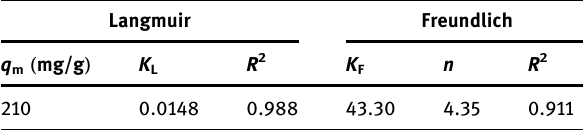
Table 2: The parameters of Freundlich and Langmuir isotherm models for the removal of Cr ( VI ) on the surface of PDA/NC nanocomposite Langmuir